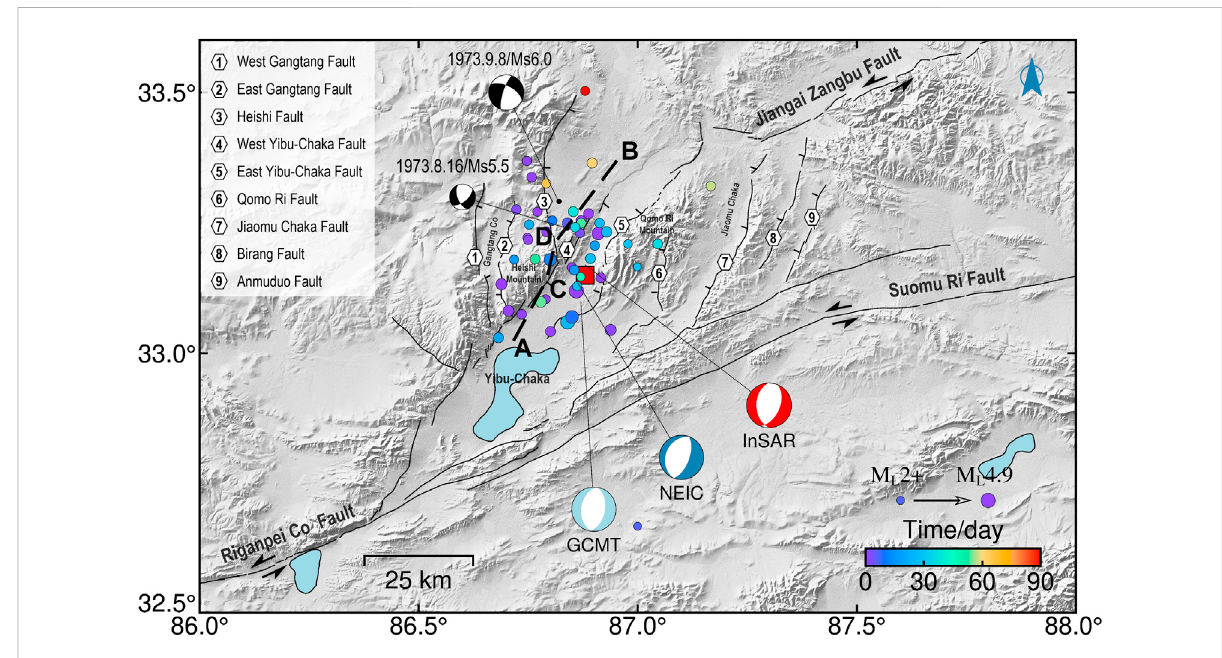
FIGURE 2 Topographic and tectonic setting mapof theYibu-Chakagraben. Black lines indicate regional active faults modi fi edafter Taylor and Yin (Taylor and An, 2009) and interpreted from satellite images. Focal mechanism solutions of the 2020 Nima event from different organizations in Table 1 and three color beach balls denote focal mechanisms of the mainshock from the GCMT and USGS catalogs, and this paper, respectively. The solid color circles are aftershocks within 9 months after the mainshock reported in the CENC (M L ≥ 2.7) catalogs, and the circle sizes indicate the magnitude of aftershocks. The black dash line is the derived fault trace via the geodetic dataset. Captions are as for Figure